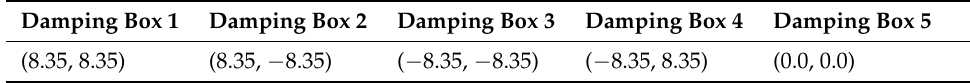
Table 4. Location of damping boxes (unit: